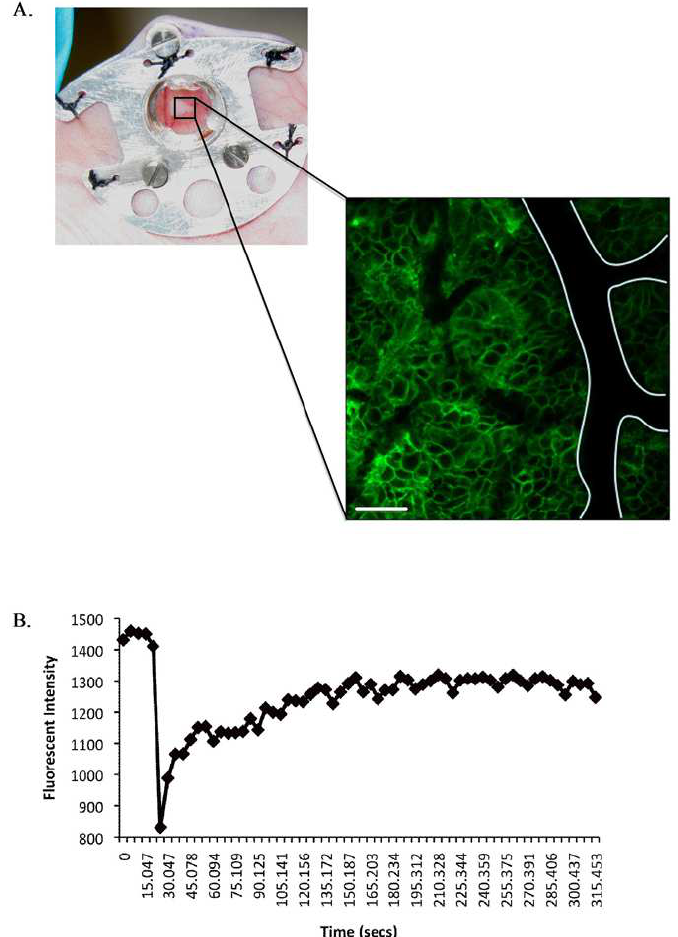
Figure 6. Intravital in vivo imaging and Fluorescence recovery after photobleaching (FRAP) to monitor E-cadherin dynamics. ( A ) Example of an optical window chamber containing a tumor implanted on the back of a CD-1 nude mouse. Inset: confocal image of GFP-E-cadherin expressing tumor cells acquired using optical window chambers, a major blood vessel is outlined. Scale bar 50 µ m. ( B ) A representative FRAP recovery curve